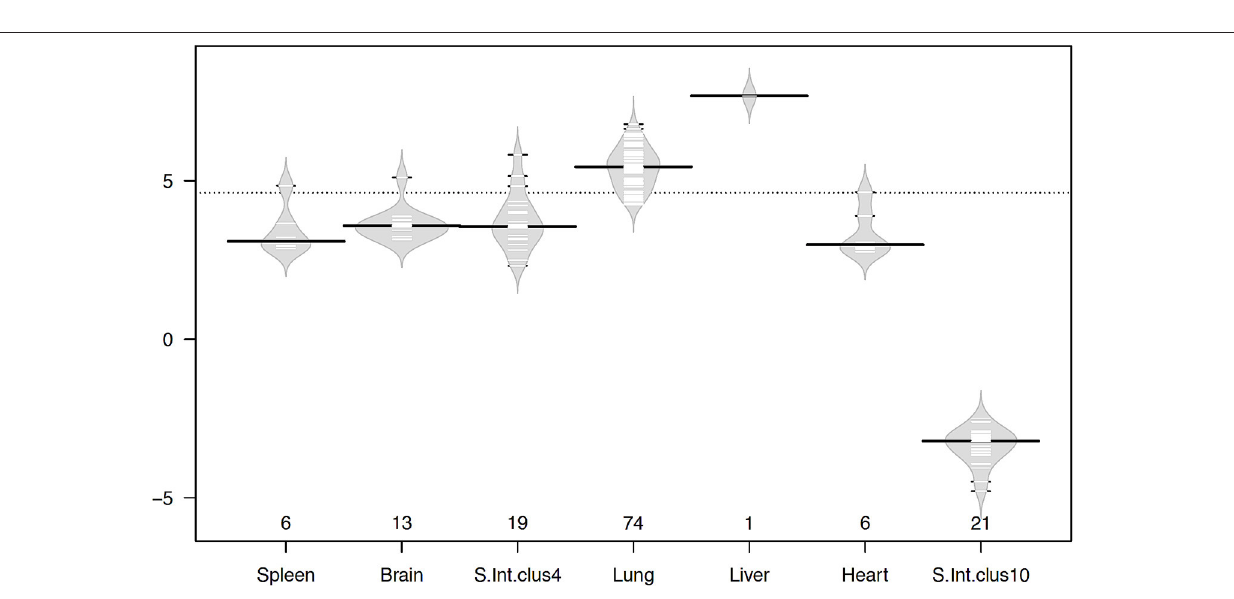
FIGURE 6 | Beanplots showing variation in the magnitude of gene expression within clusters in infected vs. uninfected tissues. The x-axis shows the number of genes of each cluster in the corresponding tissue. The y-axis indicates the average log2 fold change in gene expression. The width of the plot represents the distribution of data, short lines inside the shapes depict individual data points and heavy horizontal lines show the medians within each cluster, while the dotted line indicates the overall average. Plots were drawn using the R beanplot